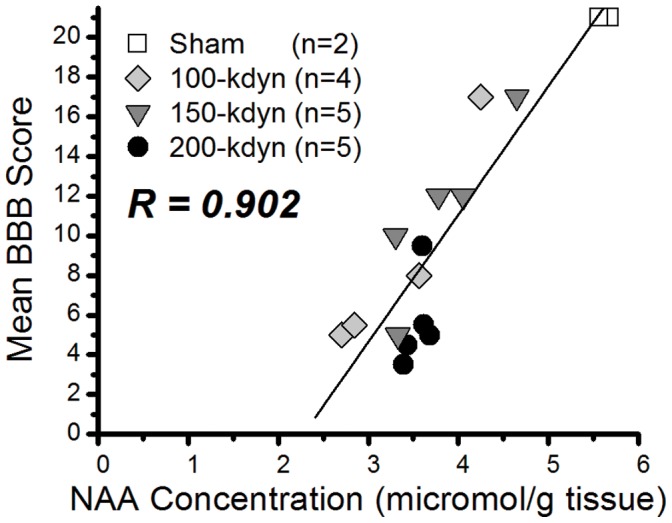
Correlation between absolute NAA concentration in the spinal cord and the corresponding BBB scores 32–34 days after SCI.SCI was induced by 100, 150 or 200-kdyn impact force. Sham animals received full BBB score ( = 21), consistent with normal movement.